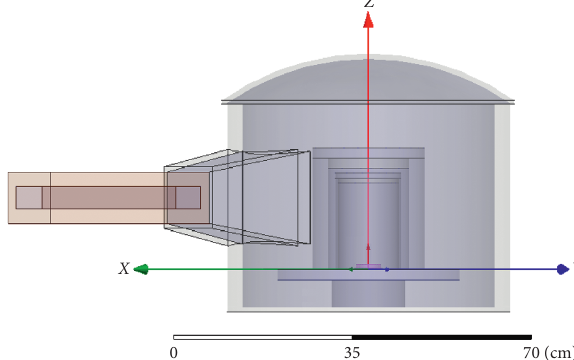
Figure 3: Schematic diagram of loading sample and setting up coordinate